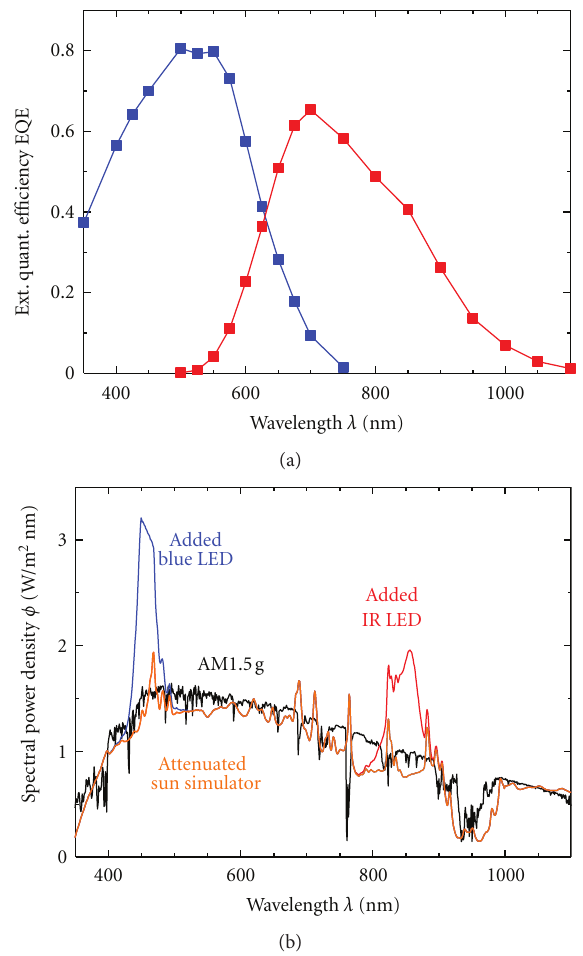
F 3: (a) External quantum efficiency EQE of the top (blue) and bottom (red) cell of the tandem solar cell sample. (b) Illuminated powerdensity.eAM1.5gstandardisgiveninblack,theattenuated sun simulator spectrum in orange, and the spectra of the full LED illumination in either blue or infrared is given in blue and red, respectively. e LED sources are chosen to affect, respectively, one of the